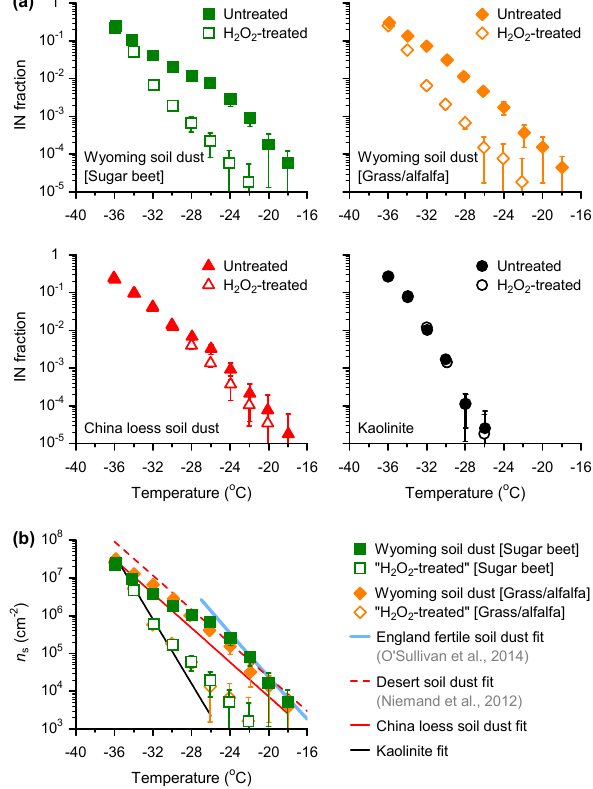
Figure 2. Ice-nucleating ability for various dusts under mixed- phase cloud conditions. (a) Fraction of 600nm particles capable of nucleating ice. The data for untreated and H 2 O 2 -treated sam- ples are shown in each figure. (b) Ice-nucleation active site densi- ties for various dusts. The n s parameterizations for various dusts are compared with the data for agricultural soil dusts (before and after H 2 O 2 treatment) collected in Wyoming. The n s parameterizations for China loess soil dust and kaolinite are based on the data pre- sented in Fig. A1a. The n s parameterizations for fertile soil dusts collected in England (O’Sullivan et al., 2014) and desert soil dusts (Niemand et al., 2012) are also shown. Error bars represent standard